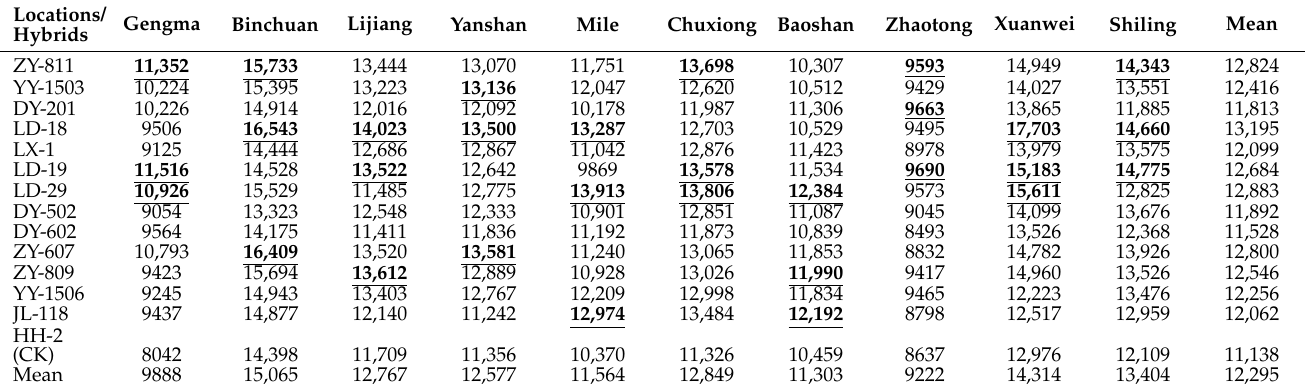
Table 5. Mean yield (kg ha − 1 ) of 14 maize hybrids across 10 environments in